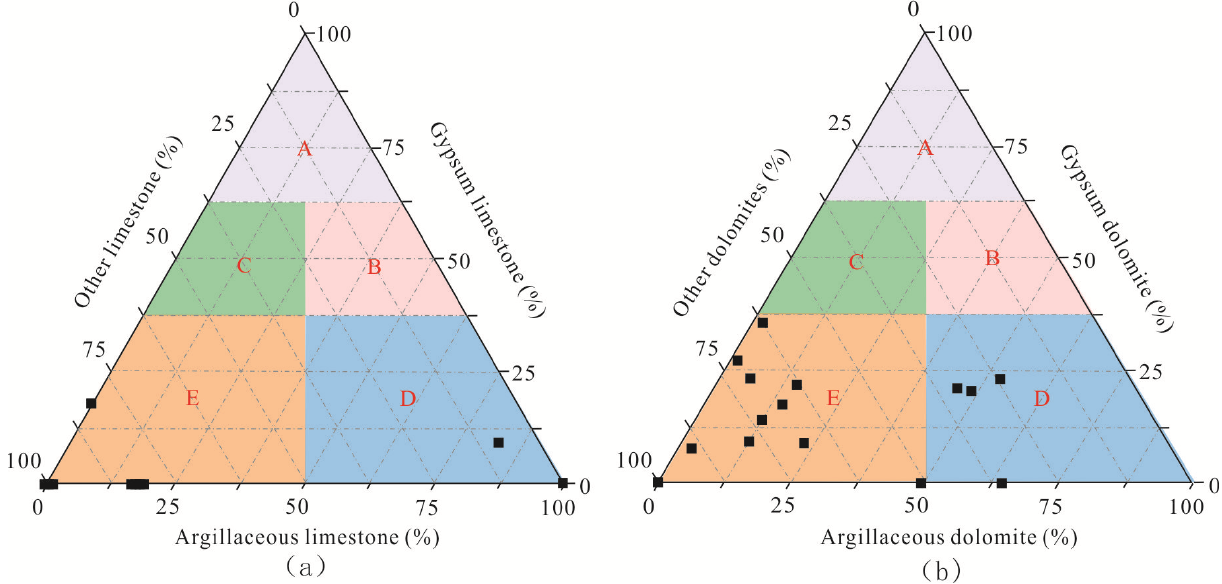
Figure 5. Lithological zoning evaluation triangle plate. ( a ) Limestone plate, ( b ) Dolomite plate.